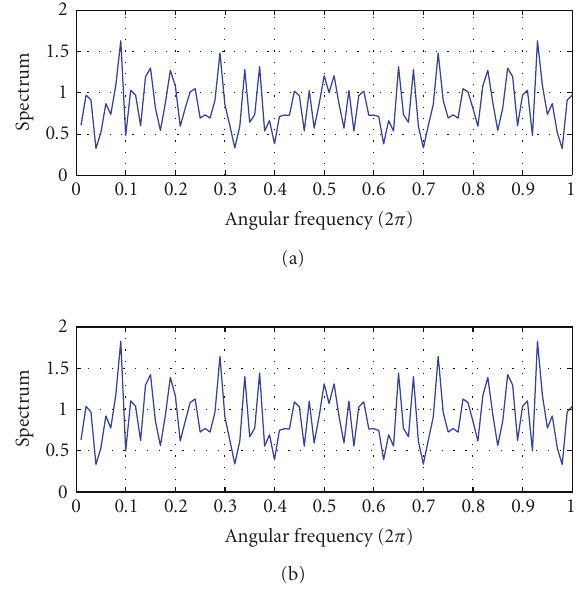
Figure 3: Spectrum of a white Gaussian signal with σ 2 x = 1, L = K = 100, λ = 1 − 1 / (5 L ), and N = 1000. (a) Recursive algorithm. (b) Fast recursive algorithm after bias